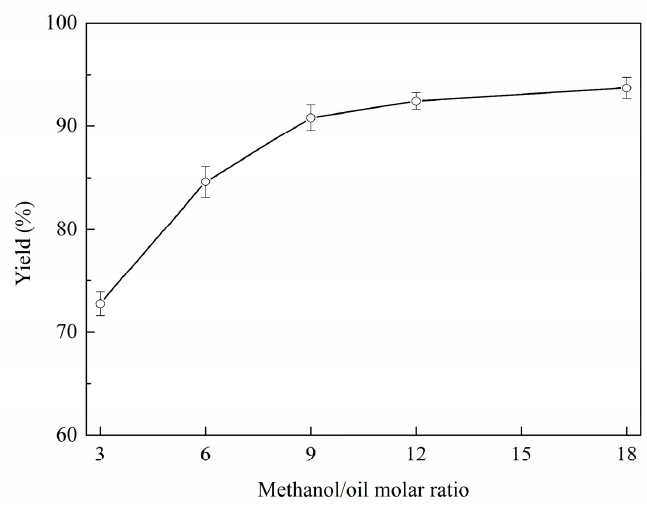
Figure 4. Effect of glycerol/oil molar ratio on the transesterification at a temperature of 120 °C, reaction time of 3 h, and IL/oil molar ratio of 0.25.